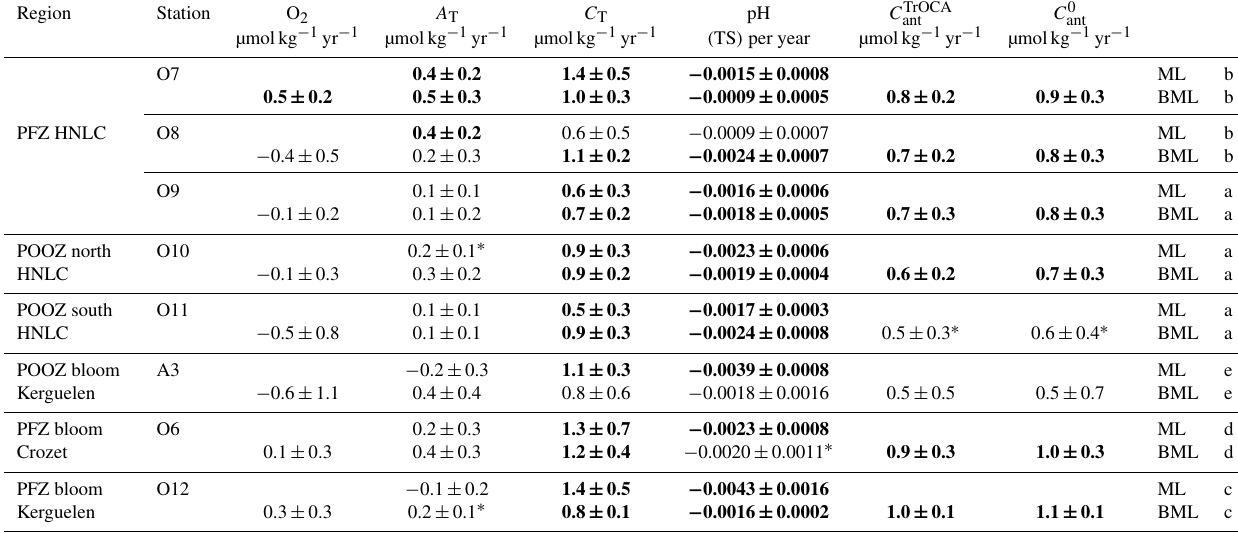
Table 1. Trends (per year) of O 2 , A T , C T , pH (total scale, TS) and C ant (TrOCA and C 0 methods) evaluated from the A T and C T data in the summer mixed layer (ML) and below the summer mixed layer (BML) at each station between (a) 1998 and 2019, (b) 1998 and 2017, (c) 1999 and 2019, (d) 2000 and 2019, and (e) 2005 and 2019. C ant is only estimated below the mixed layer (see Fig. 3). The significant trends (Student’s t test) are represented in bold (at 95%) or with a star (at 90%). Region Station O